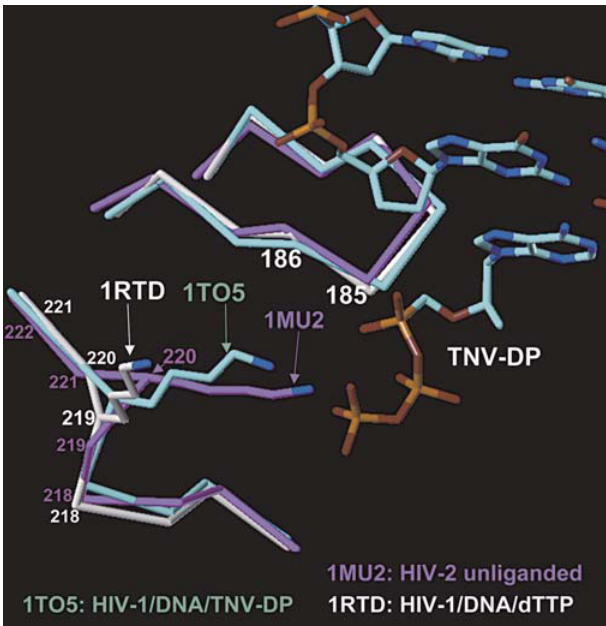
Figure 7. Position of the Side Chain of Amino Acid Residue K219 in HIV-1 RT and K220 in HIV-2 RT Unliganded HIV-2 RT (shown in magenta; PDB code 1MU2) and HIV-1 RT/ DNA/dTTP (shown in white with the dTTP and DNA omitted for clarity; PDB code 1RTD), is superimposed on the C a protein backbone of HIV-1 RT/DNA/tenofovir-diphosphate (shown in cyan; PDB code 1TO5). The residues used for the superposition were 107–112 and 155–215. The alignment shows that K220 of HIV-2 RT is the residue structurally equivalent to K219 in HIV-1 RT. DOI: